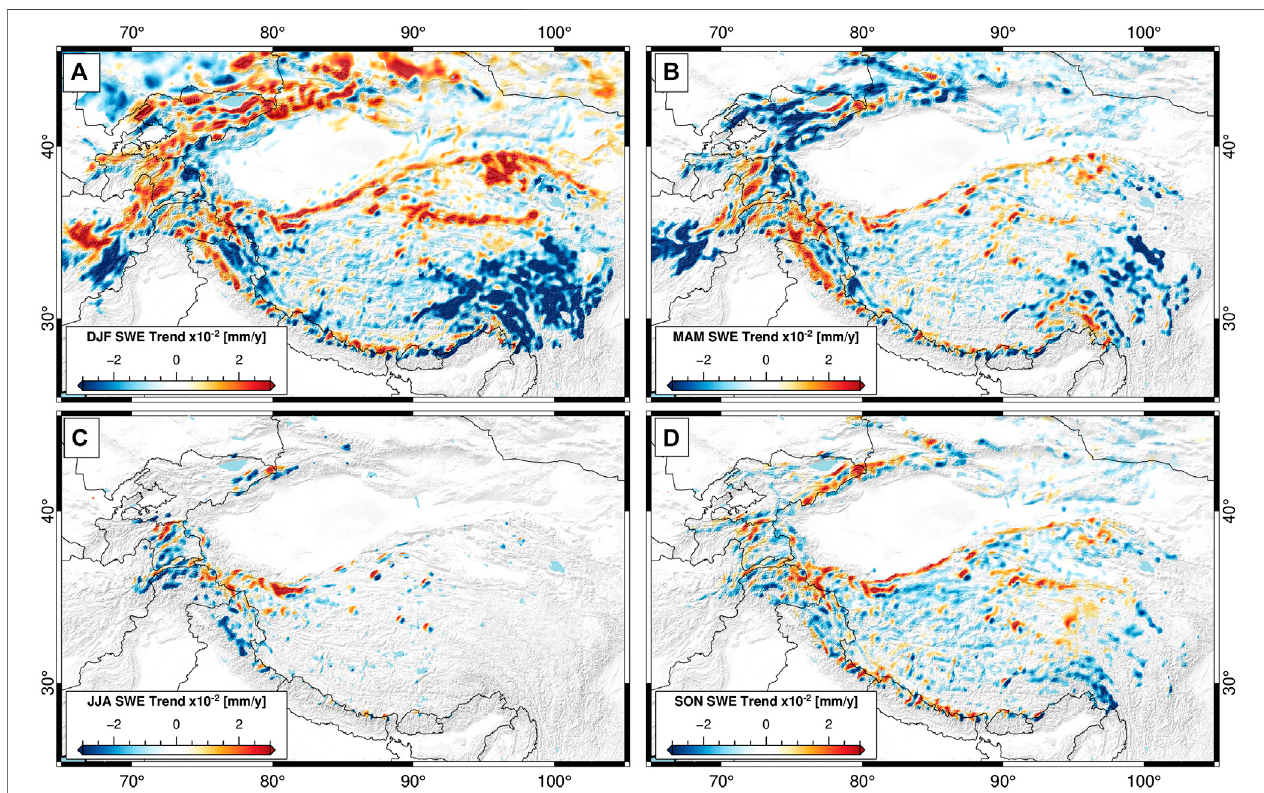
FIGURE 5 | Seasonal components of snow-water equivalent (SWE) trend (1987 – 2016). (A) December-January-February (DJF), (B) March-April-May (MAM), (C) June-July-August(JJA),and (D) September-October-November(SON)trendsallhavedistinctspatialpatterns.Notethatthemagnitudescalingoftheseasonaltrendsis threetimesaslargeasthatoftheannualtrends(see Figure3 ).TheKarakoram-KunlunShanistheonlyregiontomaintainlarge-scalepositiveSWEtrendsinthesummer months.